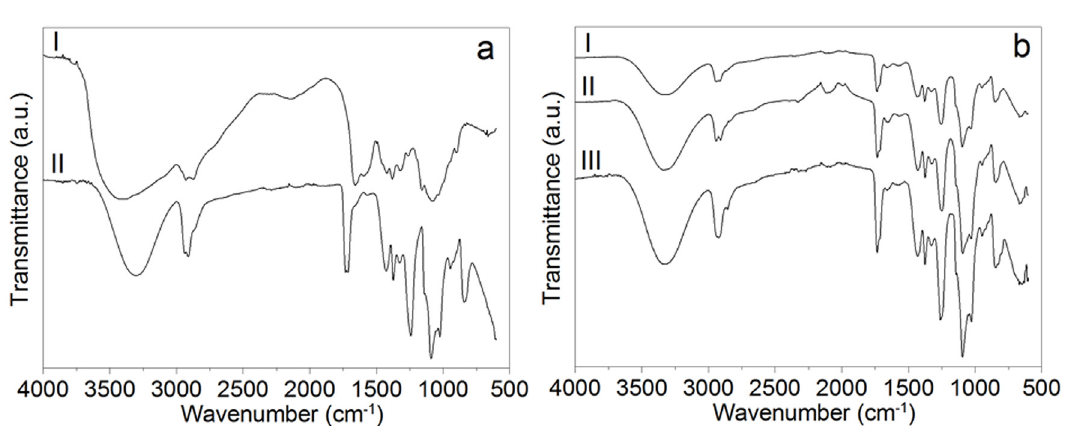
Figure 4. FTIR spectra for (a) chitosan (CS, trace I) and poly(vinyl alcohol) (PVA, trace II); (b) PVA/CS mats at 70:30 (M3, trace I), 75:25 (M4, trace II) and 85:15 (M6, trace III) compositions.